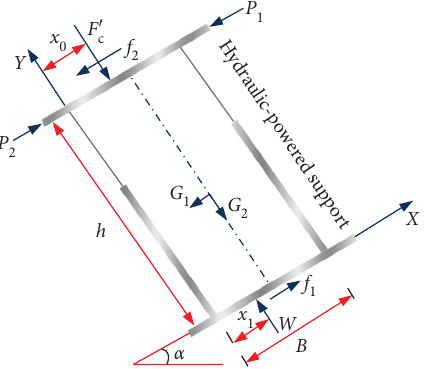
Figure 14: Mechanical model of the hydraulic-powered